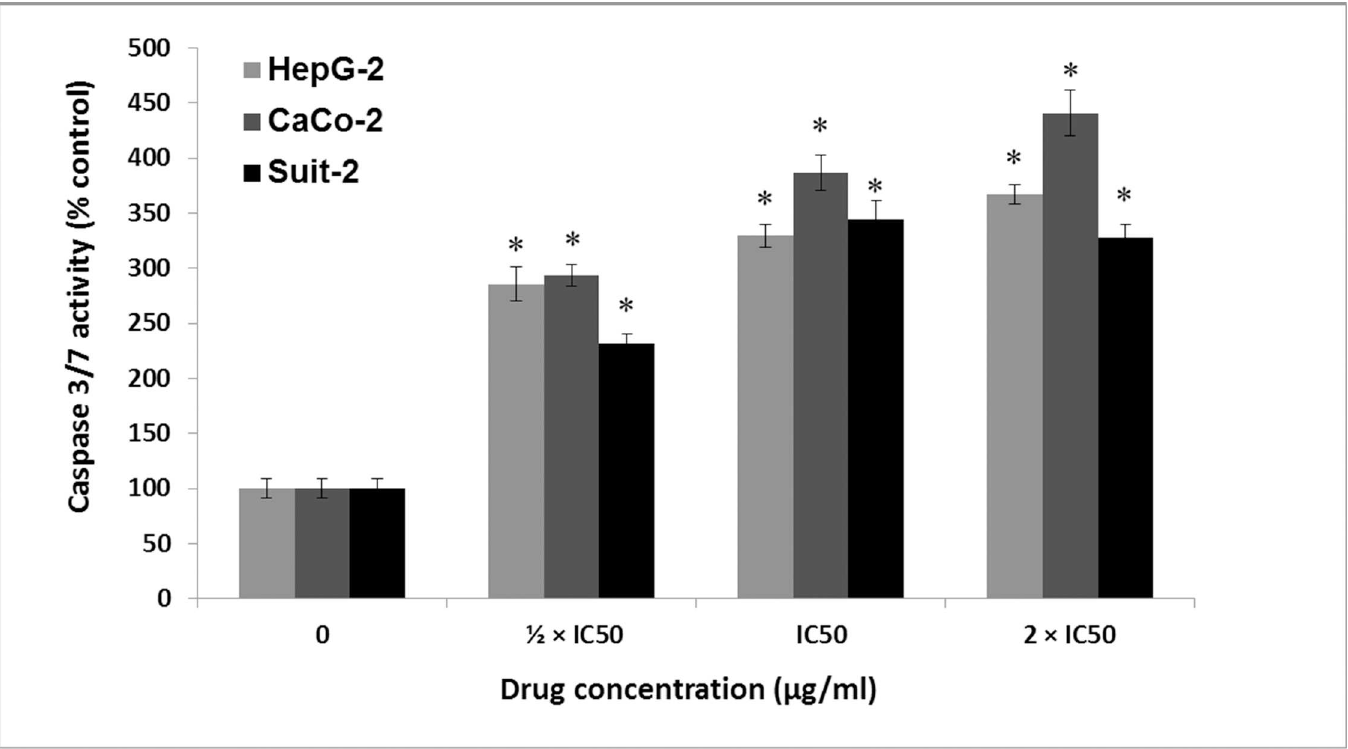
Fig 2. Apoptotic effect of fisetin as shown by measuring caspase3/7 activatioin. Cells were treated with gradientconcentrations of fisetin and caspase 3/7 assay was carried out. Results are presented as mean value (M) ± S.E.M. of at least 3 independentexperiments (4 replica each), * significantly different from control group (P < 0.001) using 2 way ANOVA